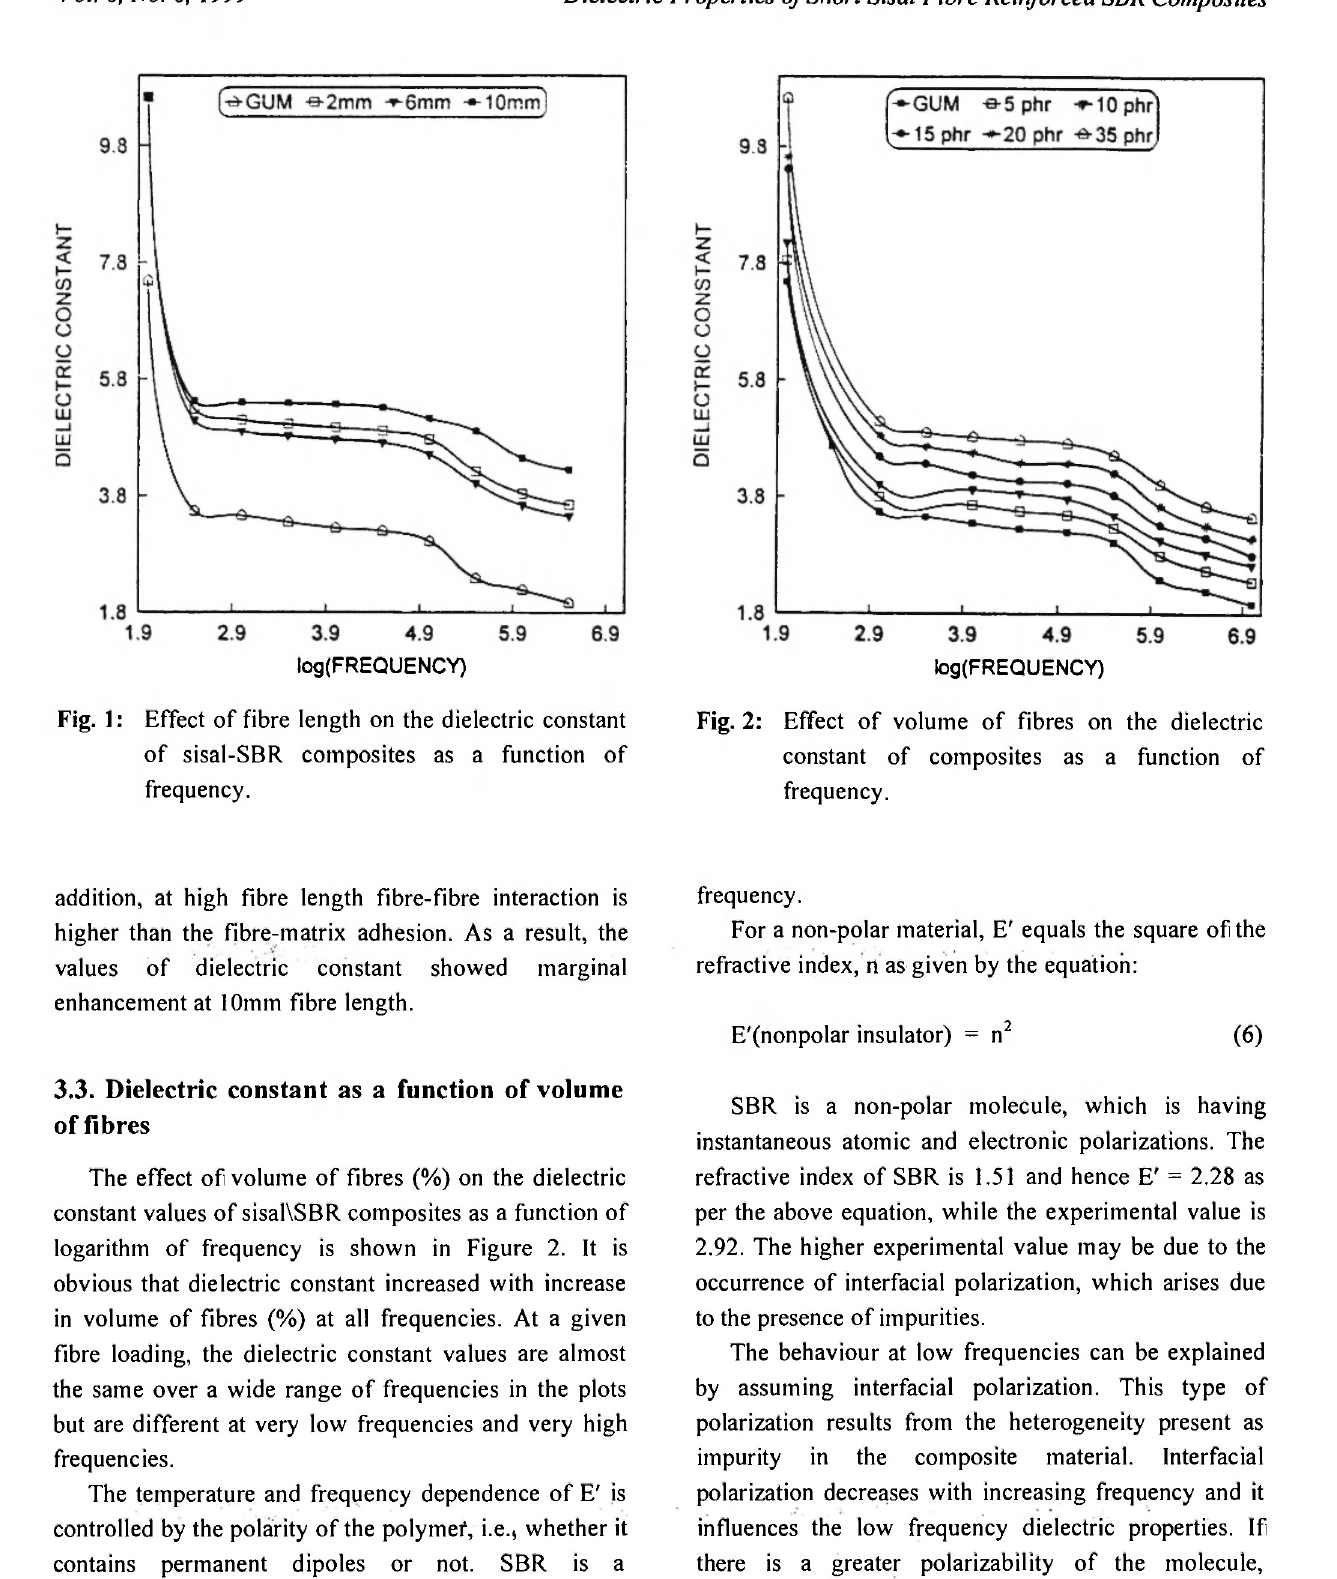
Fig. 2: Effect of volume of fibres on the dielectric constant of composites as a function of frequency.